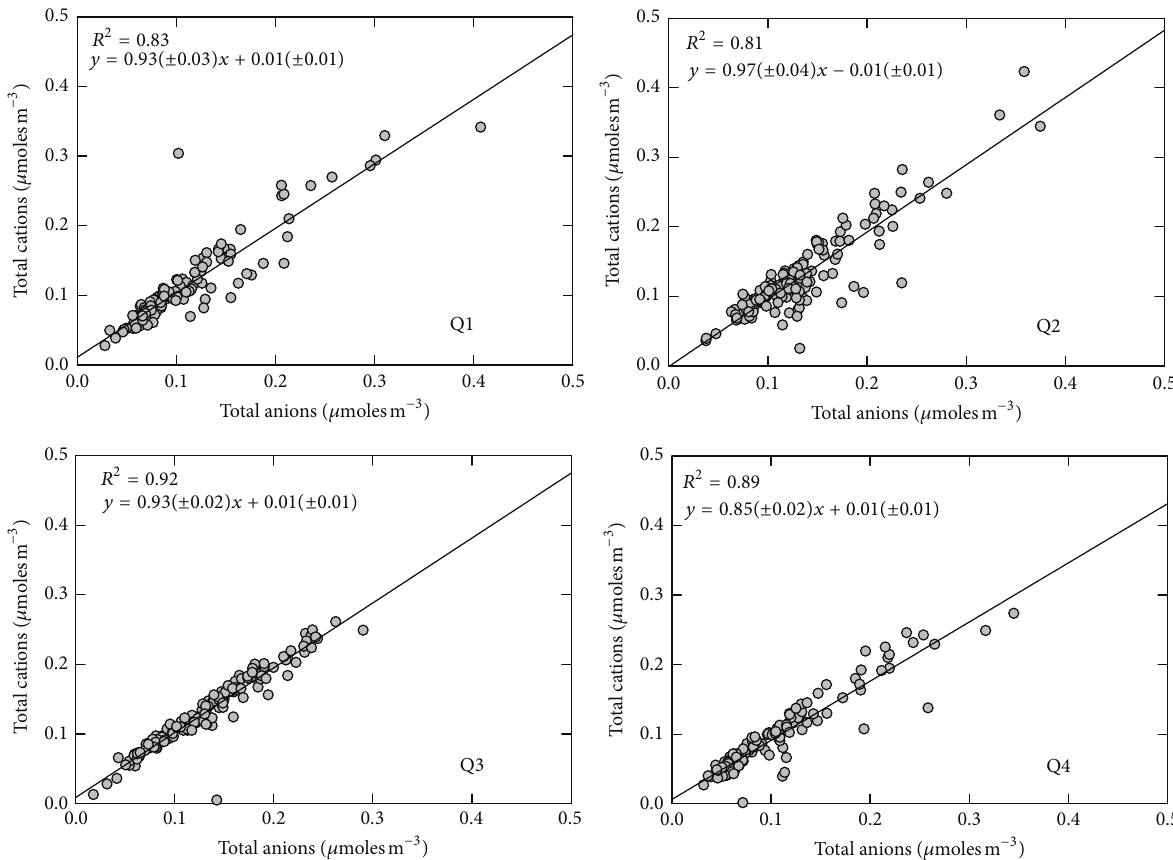
Figure 4: Correlations between a total of cations and anions over the study period.